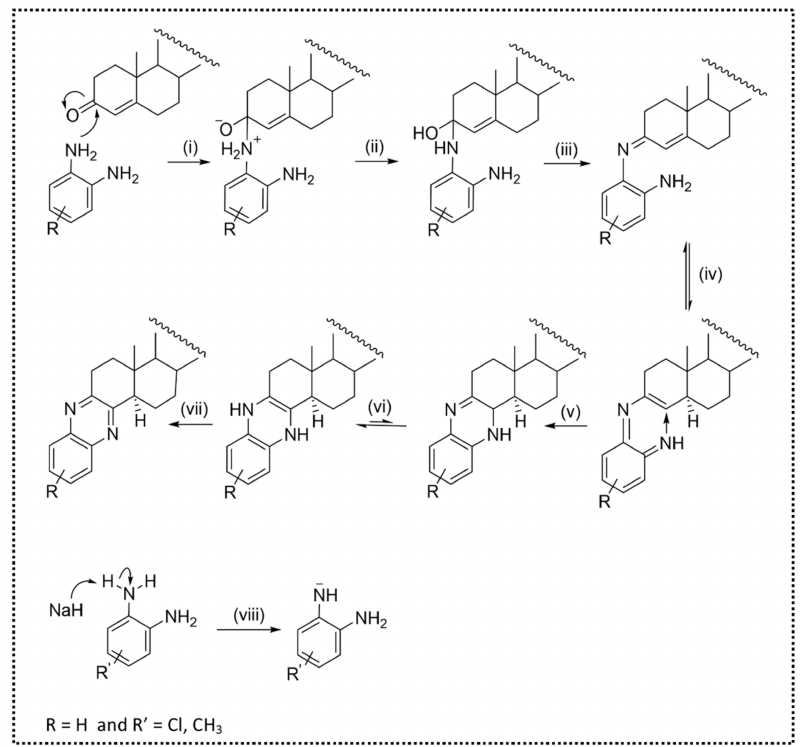
Figure 2. Reaction mechanism for the synthesis of steroidal quinoxalines: (i) attack of amino group at carbonyl carbon, (ii) proton transfer, (iii) loss of water molecule, (iv) attack of amine group at C=C, (v) transfer of proton from N to C, (vi) proton rearrangement, (vii) oxidation to loose protons from N; (viii) activation of amine group of substituted diaminobenzene using NaH.